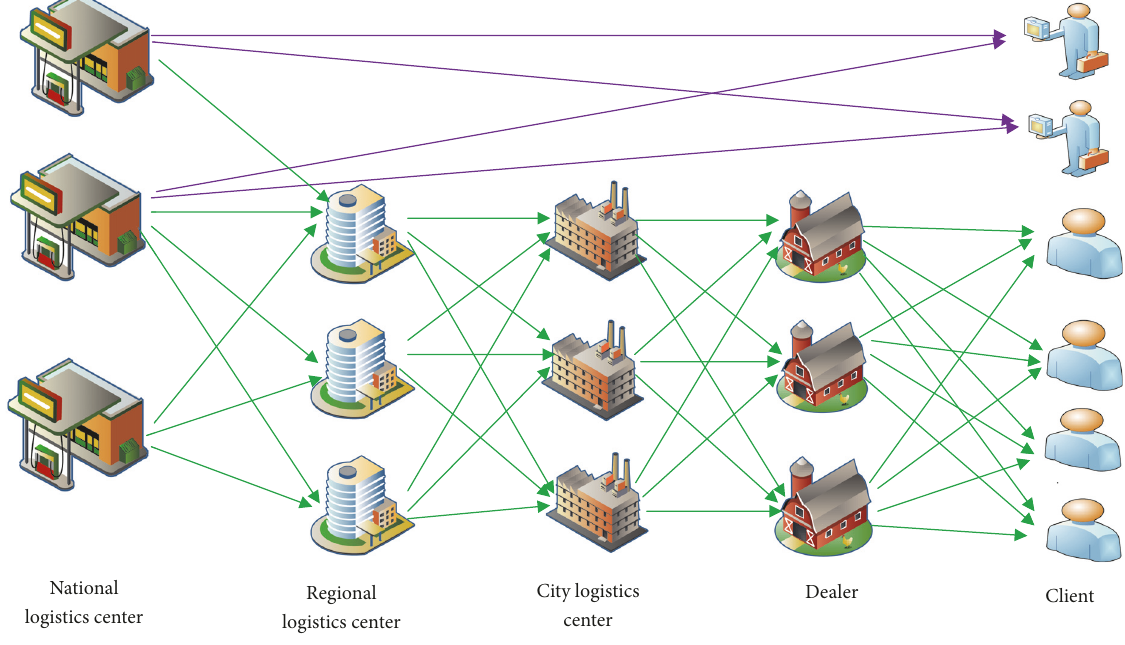
Figure 1: Supply chain distribution